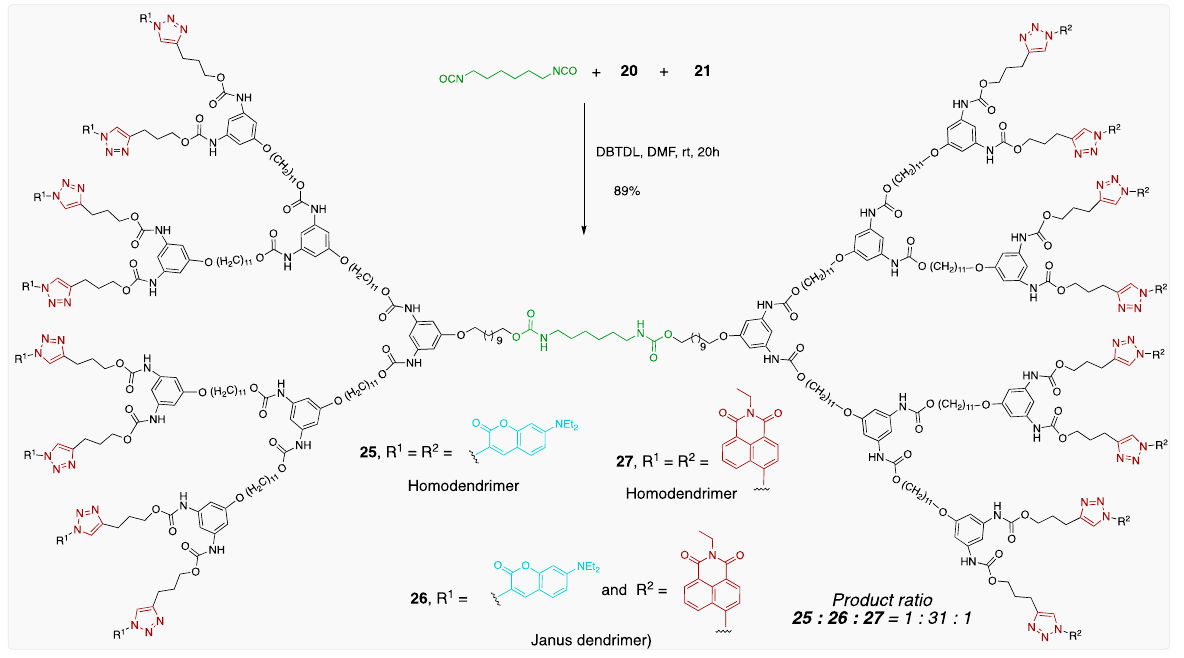
Scheme 8. Synthesis of the third ‐ generation homo ‐ and Janus dendrimers 25 – 27